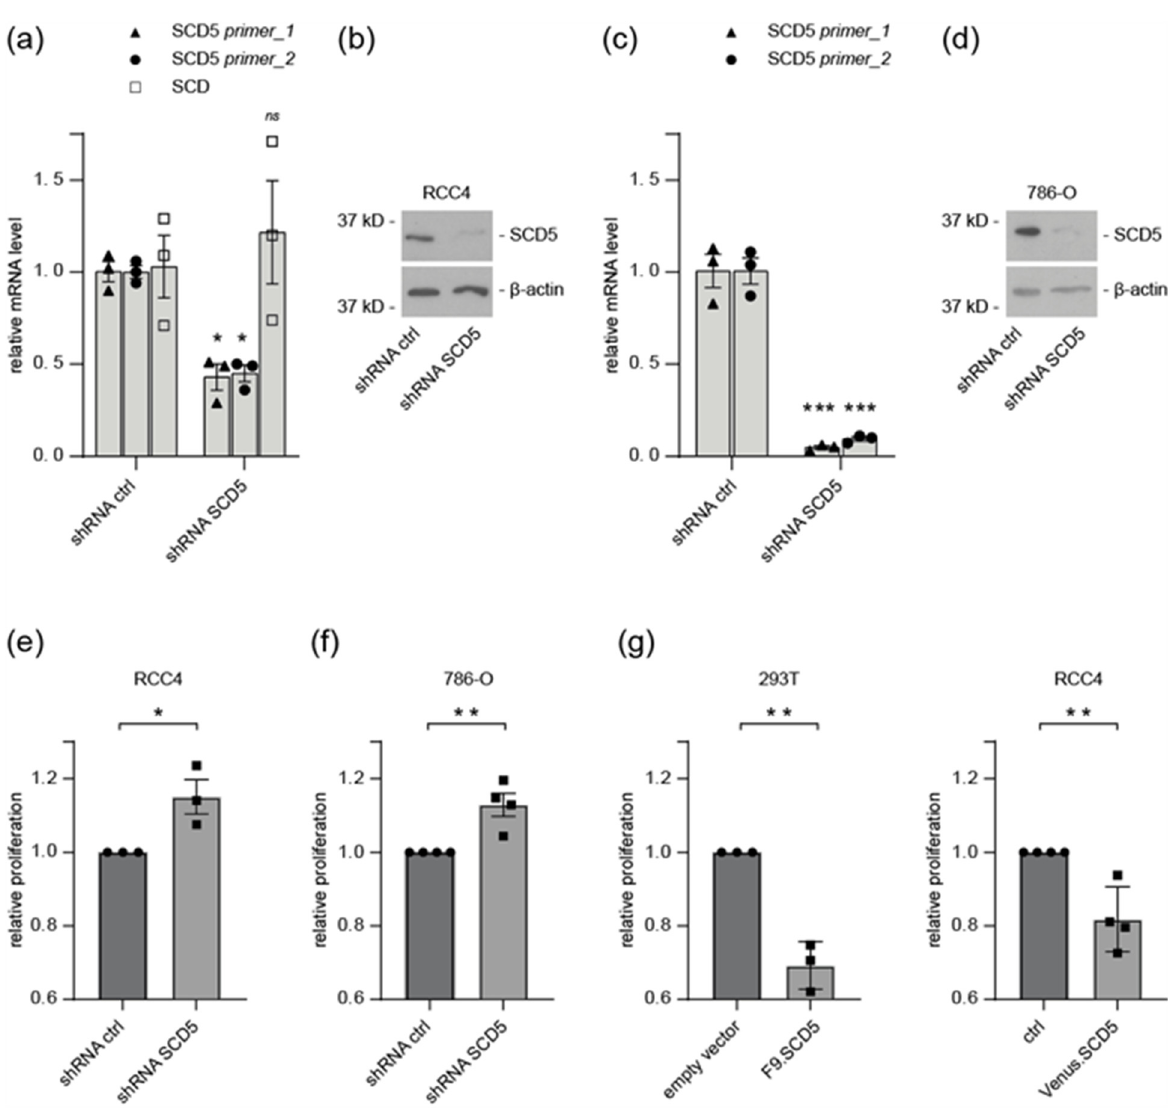
Figure 5. SCD5 affects cell proliferation. ( a ) RT-qPCR analysis of SCD5 and SCD in RCC4 cells infected with inducible control or SCD5 -specific shRNA. Two different primer sets were used for SCD5 mRNA analysis. SCD5 shRNA does specifically affect SCD5, as SCD was not down regulated. HSPCB was used as the reference gene, n = three. Data are presented as mean ± SEM. * < 0.05 ( t -test). ( b ) Western blot of shRNA-mediated knockdown of SCD5 in RCC4 cells. ( c ) mRNA levels of SCD5 in 786-O cells infected with control-shRNA or SCD5 -specific shRNA, assayed by qPCR; β -actin was used as the reference gene. n = three. Data are presented as mean ± SEM. *** p < 0.001 ( t -test). ( d ) Western blot of shRNA-mediated knockdown of SCD5 in 786-O. ( e ) Knockdown of SCD5 induces cell proliferation. Cell viability of RCC4 cells upon shRNA SCD5 knockdown was assayed compared to control. Data are presented as mean ± SEM of three independent experiments. * p < 0.05 ( t -test). ( f ) Cell viability of 786-O cells upon shRNA SCD5 knockdown was assayed compared to control. Data are presented as mean ± SEM of three independent experiments. ** p < 0.01 ( t -test). ( g ) Overexpression of SCD5 in 293T and RCC4 cells reduces cell proliferation. Cell viability was assayed in 293T and RCC4 cells transfected with Flag-tagged SCD5, or transduced with Venus-tagged SCD5, as indicated. Data are presented as mean ± SEM of three independent experiments. ** p < 0.01 ( t -test).